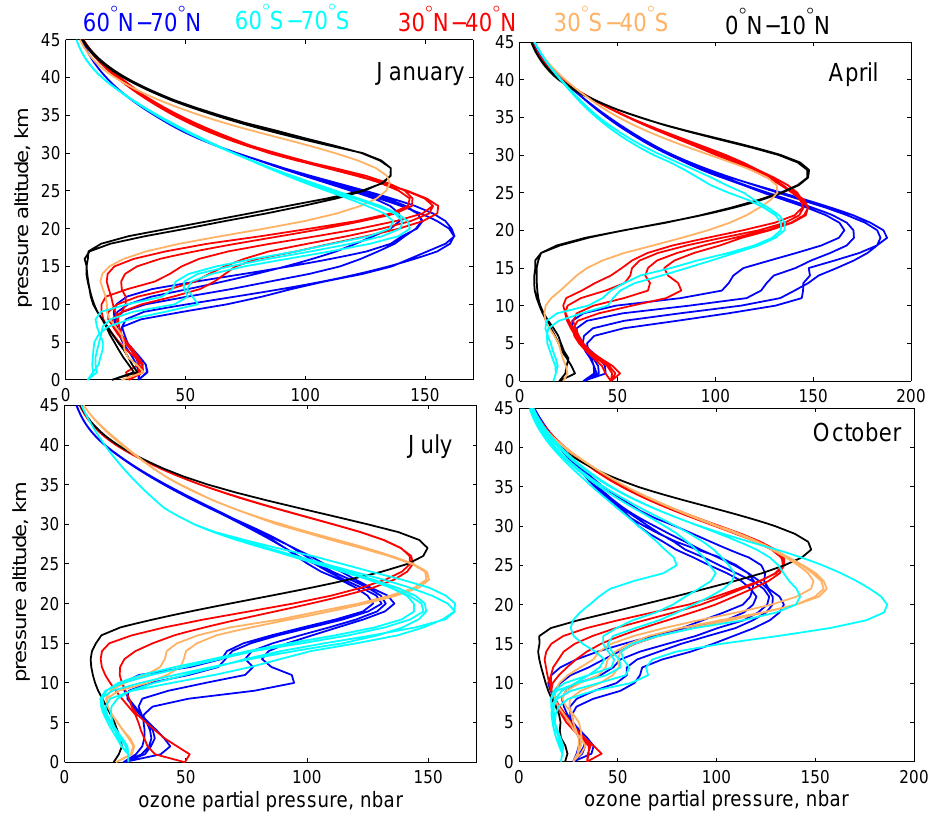
Fig. 8. Examples of ozone profiles in the linked ozone–tropopause climatology TpO 3 for January, April, July and October, in different latitude zones indicated by different